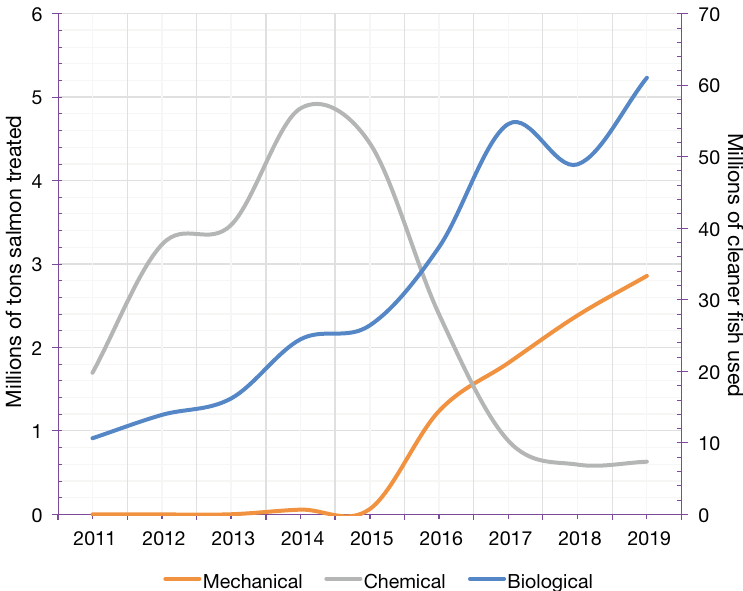
Fig. 1. Sea lice treatments used by the Norwegian aquaculture industry between 2011 and 2019. Mechanical treatments include thermal application of Thermolicer and Optilicer. Chemical and mechanical treatments are ex - pressed in millions of tonnes of salmon treated, while biological treatments are expressed in millions of cleaner fish used (for references and statistics, see the Supplement at